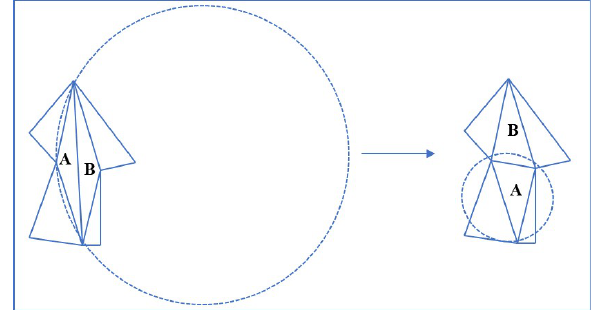
Figure 4. Illustration of the optimization procedure of the boundary triangles using LOP algorithm.